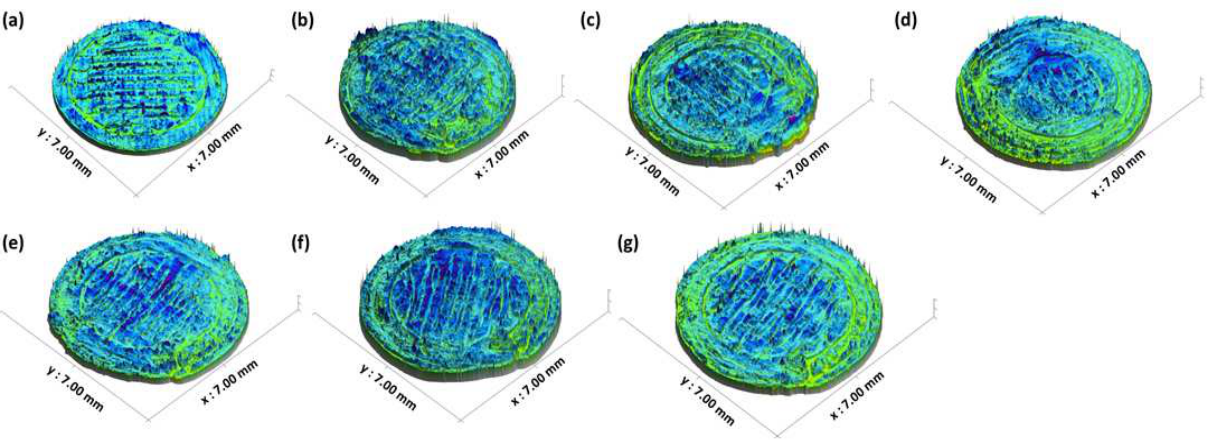
Figure 7. Three-dimensional surface texture images of 3D-printed tablet: ( a ) F1 (1 shell with 0% infill); ( b ) F2 (2 shells with 0% infill); ( c ) F3 (3 shells with 0% infill); ( d ) F4 (4 shells with 0% infill); ( e ) F5 (2 shells with 10% infill); ( f ) F6 (2 shells with 20% infill); and ( g ) F7 (2 shells with 30% infill).